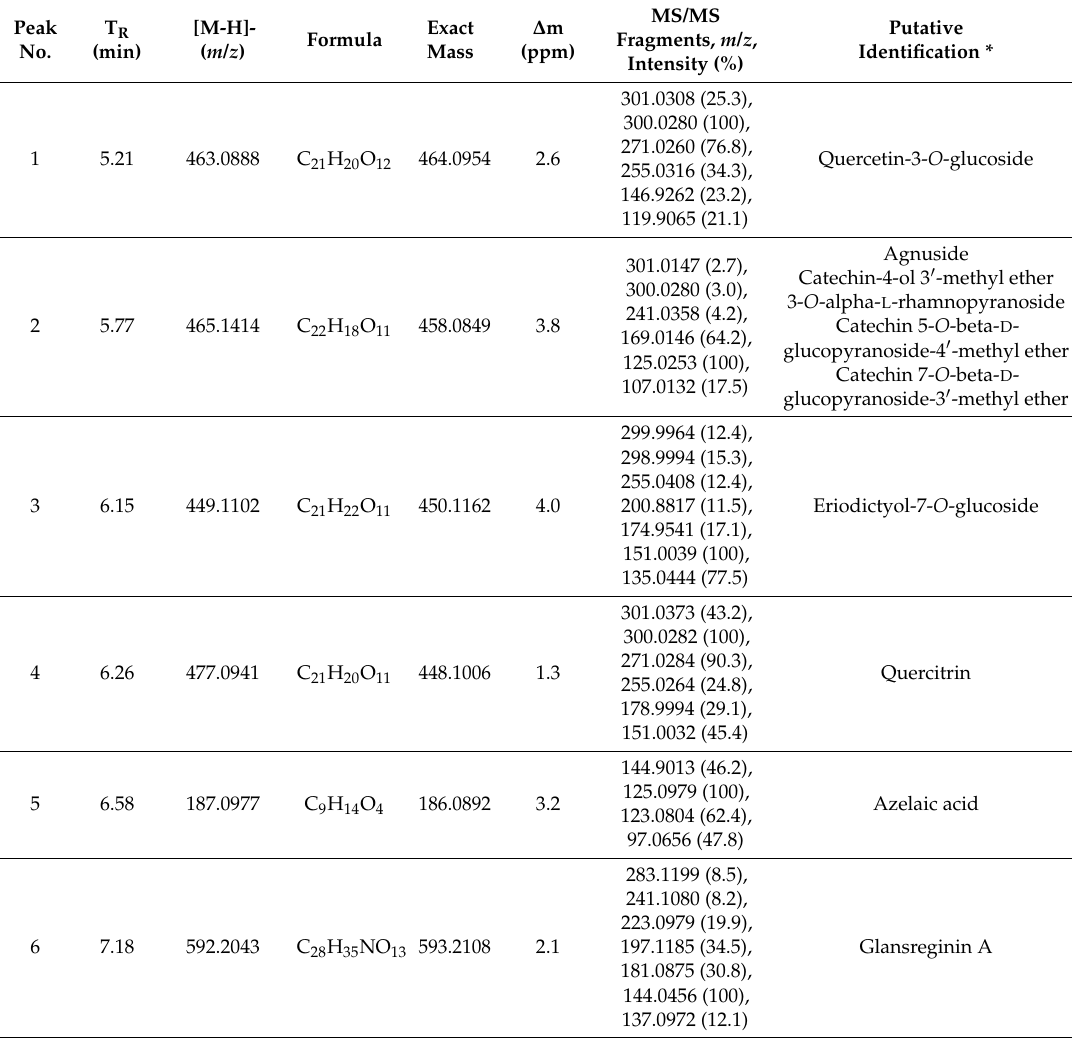
Table 1. Putative bioactive compounds responsible for antibacterial activity in black walnut (Mystry). Peak